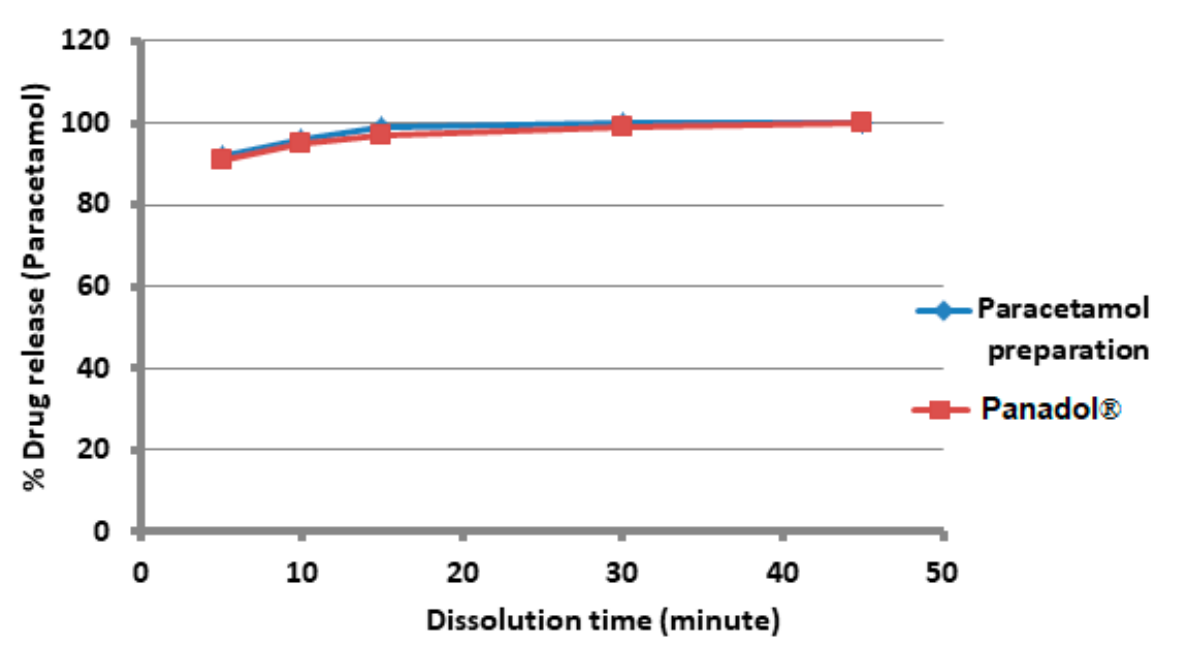
Figure 6. Percent drug release of paracetamol with 60% MCC, 30% starch, and 10% Mg silicate that has been prepared and Panadol ® 500 mg. Each point is based on the average of six tablets.